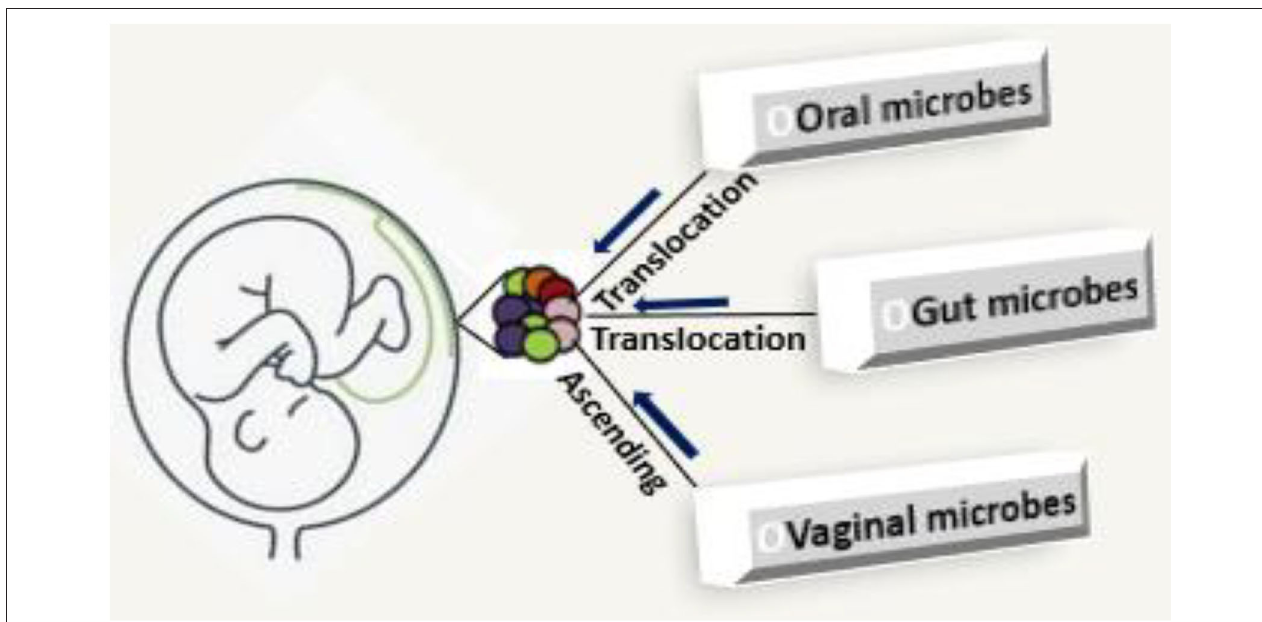
FIGURE 1 | Seeding of placental microbiome; microbes ascend from the vagina, gut, and oral cavity which are internalized and translocated by hematogenous spread to the